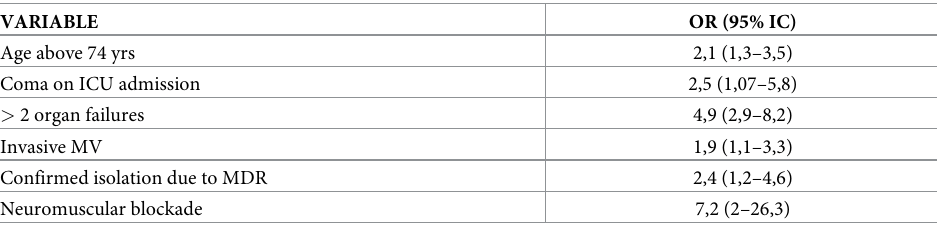
Mortality upon ICU discharge, n (%) Mortality upon hospital discharge, n (%)